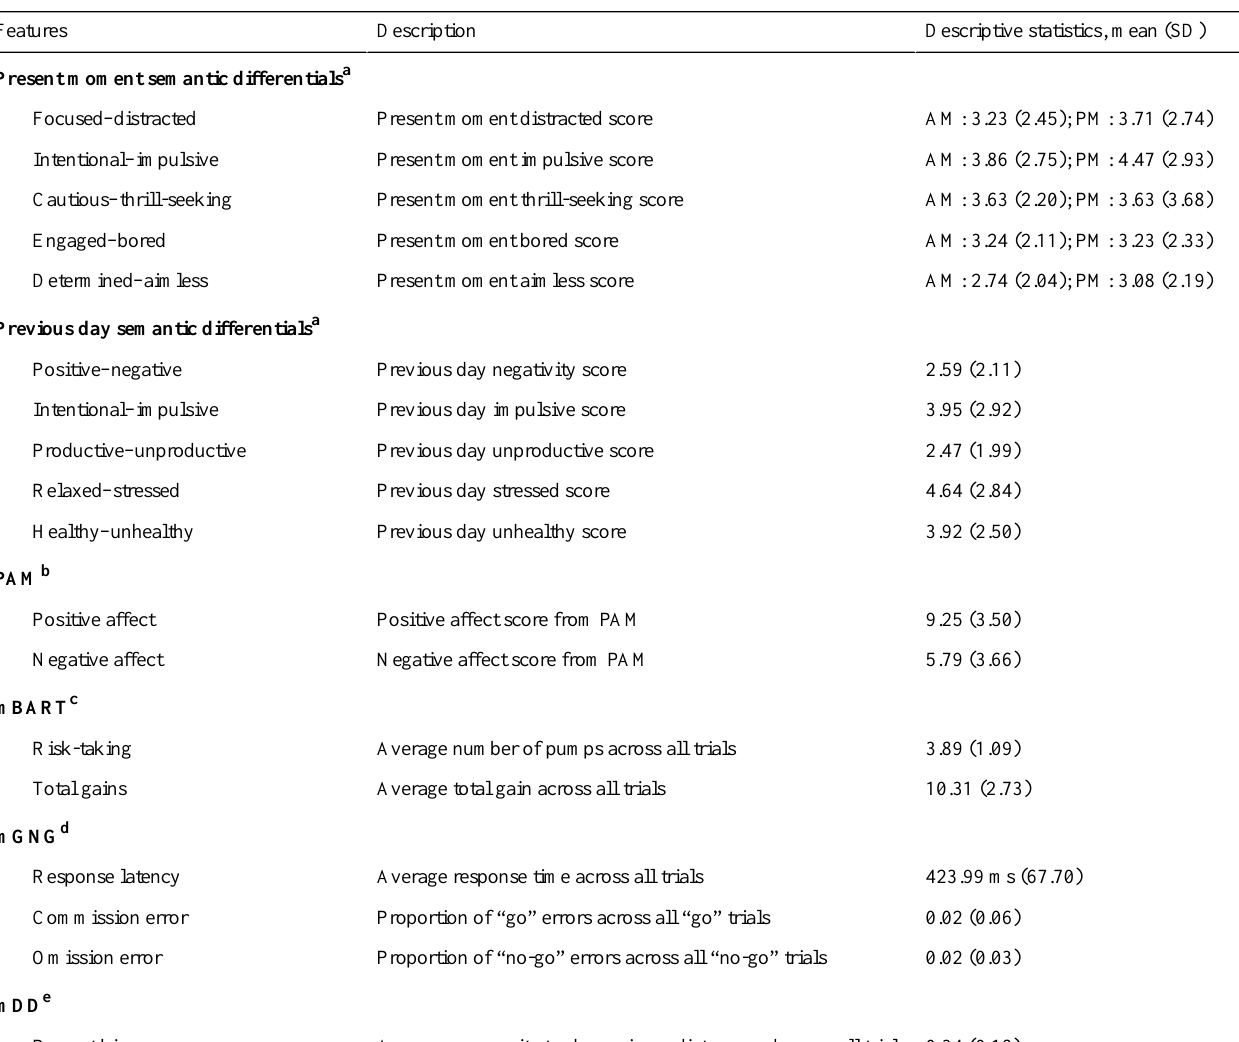
Table 3. List of features from ecological momentary assessments and active tasks.